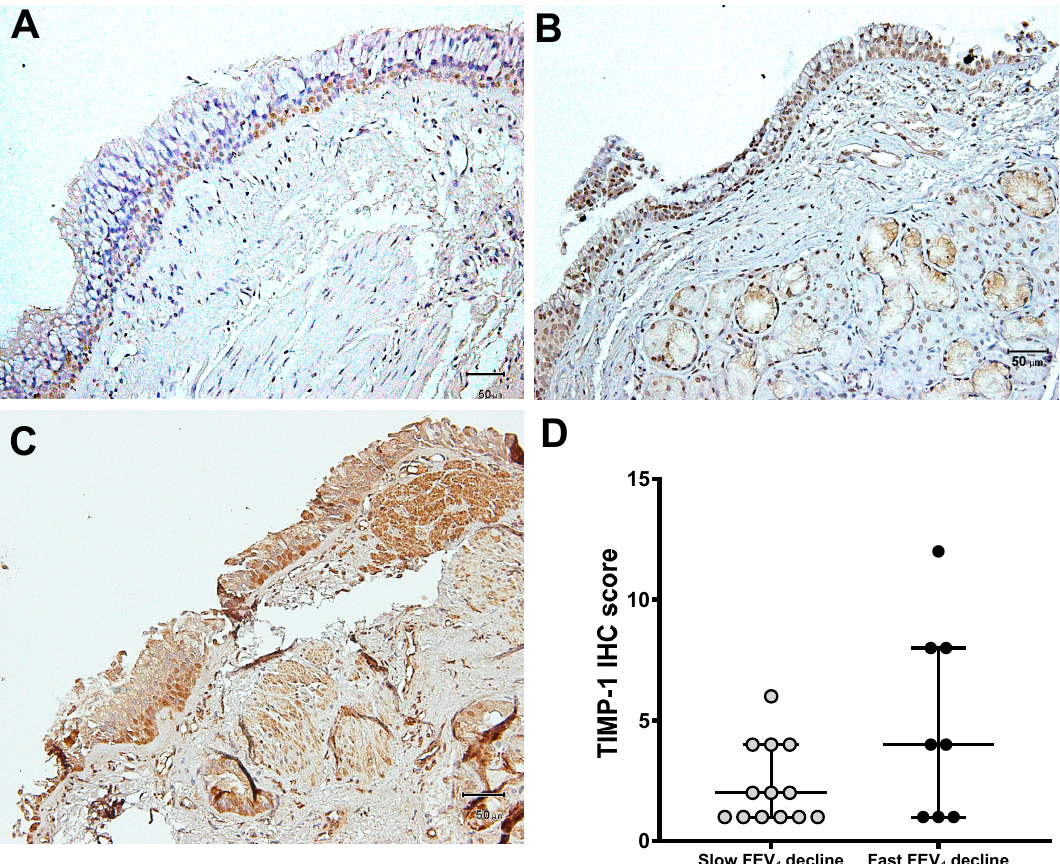
Figure 2. Immunohistochemical expression levels of TIMP-1. An avidin–biotin complex immunohistochemical study for TIMP-1 expression was performed in airway tissues derived from asthmatic patients with a slow FEV 1 decline (A and B) and a rapid FEV 1 decline (C). Positive staining was defined as brown–yellow particles or tan–brown particles in the cytoplasm (magnification, 200 × ). ( A ) airway tissue with weak staining (score 1); ( B ) airway tissue with moderate staining (score 6); ( C ) airway tissue with strong staining (score 12); ( D ) immunostaining of TIMP-1 was scored through a semi-quantitative assessment by calculating the intensity and percentage of positive cells. The central horizontal lines indicate the median, and the error bars (upper and lower horizontal lines) are the 75th percentile and 25th percentile, respectively. IHC, immunohistochemistry; TIMP-1, tissue inhibitor of matrix metalloproteinase-1.